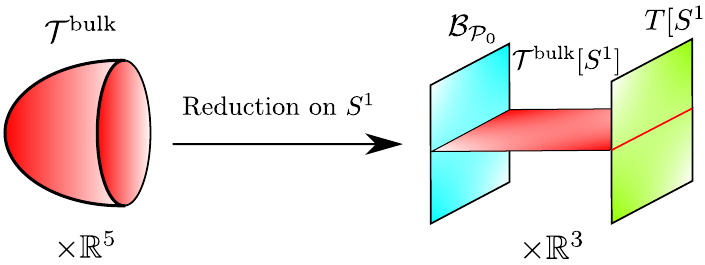
Figure 9 . Three-dimensional operators in T bulk wrapping the disk Σ become 2d surface operators stretched between the topological boundary B two boundaries, they become line operators in T [ S 1 , P